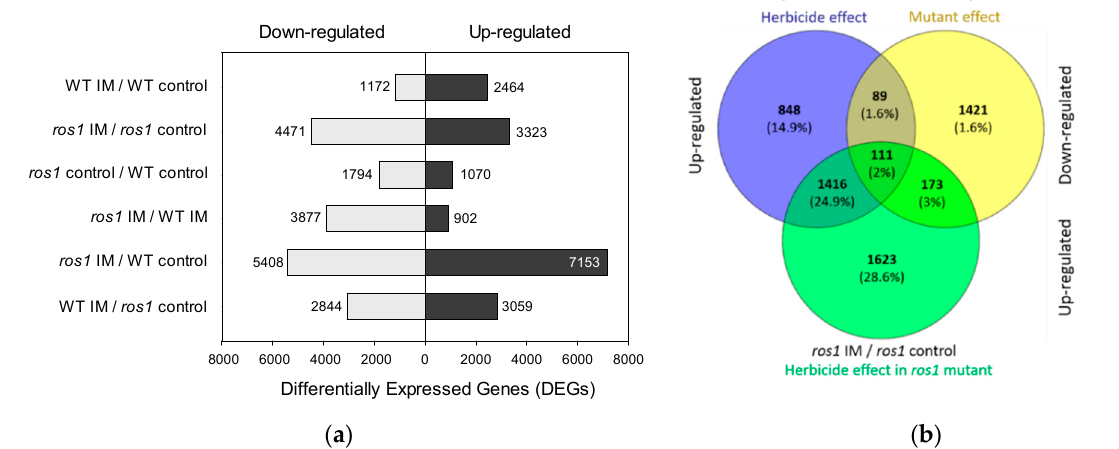
Figure 5. ( a ) Differentially expressed genes (DEGs) in response to imazethapyr (IM) and in the control condition in wild type (WT) and ros1 mutant. The number of up and downregulated genes is represented in black and gray bars, respectively. The differences in gene expression were obtained based on the Log2 Fold Change ≥ 2 and adjusted p -value < 0.05 in Cuffdiff. ( b ) Venn diagrams showing the overlap of genes comparing genes inducted by IM in WT (herbicide effect—blue circle), with repressed genes in ros1 (mutant effect—yellow circle) and effect of IM in ros1 (herbicide effect on mutant—green circle).